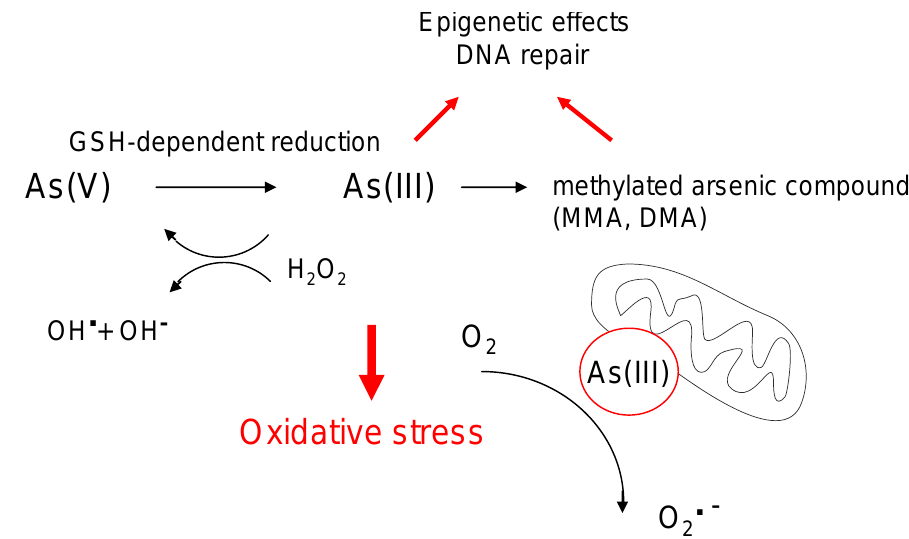
Figure 1. Carcinogenic mechanisms of arsenic compounds. Inorganic arsenic compounds and methylated metabolites display similar genotoxic properties. Generation of oxidative stress is regarded as central mechanism in As-mediated carcinogenesis. However, the precise mechanisms of ROS-formation are not yet clarified. A mitochondria-dependent mechanism and a H O /hydroxy radical pathway are discussed. In addition, arsenic affects 2 2 DNA methylation and DNA repair enzymes (see text for